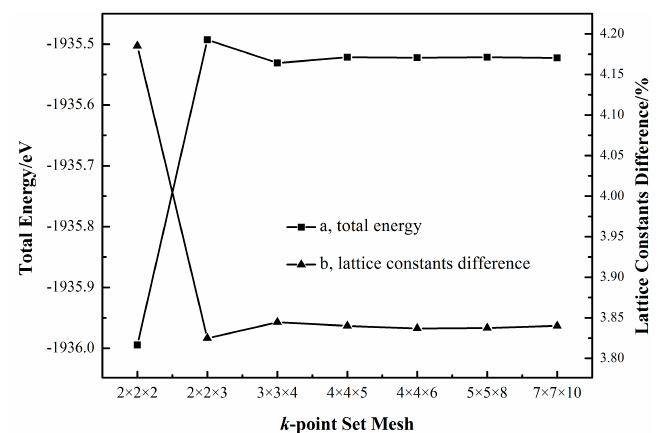
Figure 2. The dependence of the total energy ( a ) and lattice constants difference ( b ) on the k -point set with a fixed cutoff energy of 340 eV.